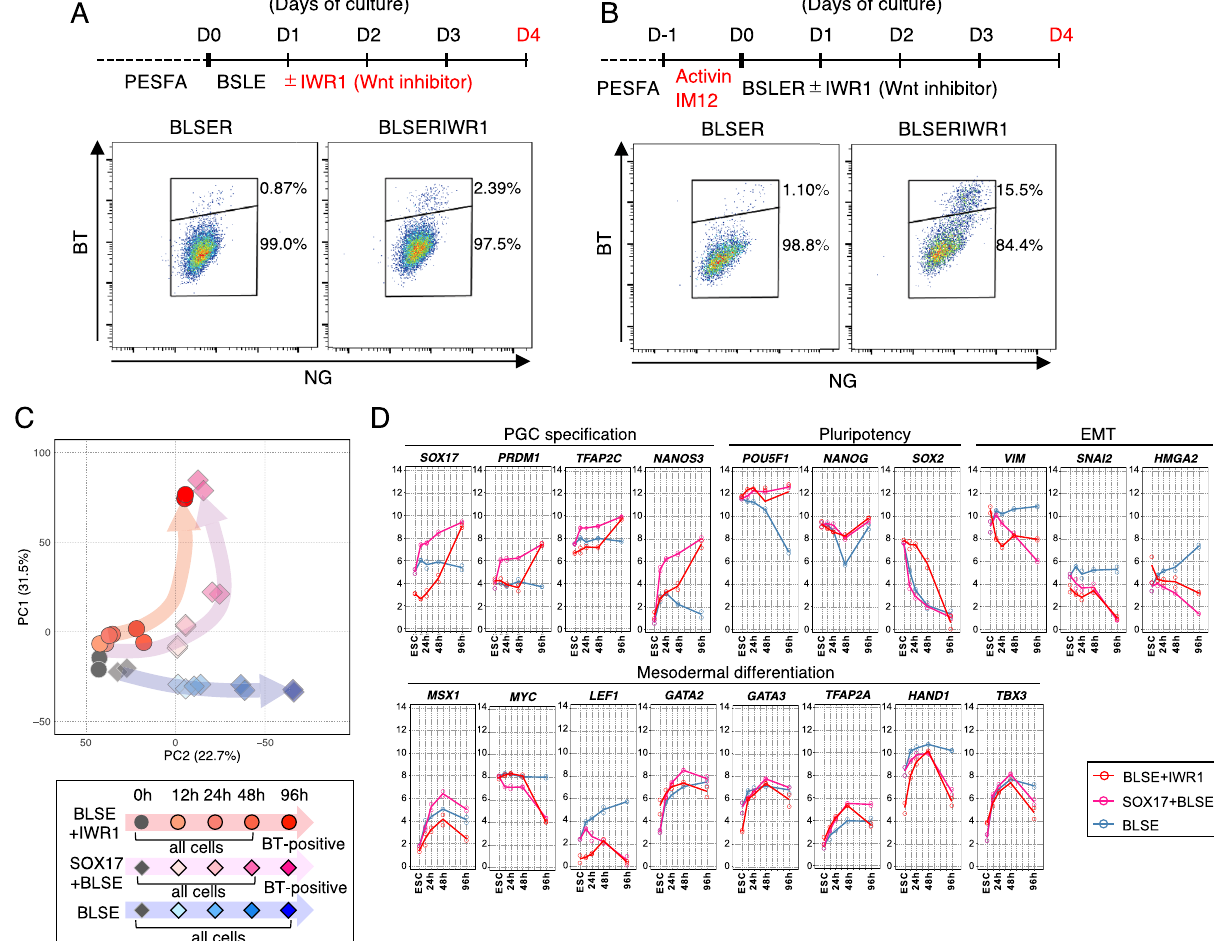
Figure 3. Efficient induction of BTNG-positive cells in the presence of IWR1. ( A ) Enhanced induction of BTNG-positive cells with IWR1. Shown are the schematic time course of the BTNG-positive cell induction with IWR1 (top) and a representative FACS plot of cells at day 4 of induction (bottom). ( B ) Further enhancement of the BTNG-positive cell induction with the preculture period and IWR1. Shown are a schematic time course of the BTNG-positive cell induction with the preculture period and IWR1 (top) and a representative FACS plot of cells at day 4 of induction (bottom). ( C ) Differentiation trajectories during the induction of BTNG-positive cells with BLSE + IWR1. Shown are PCA plots of cjESCs and cells at 12, 24, 48, or 96 h of culture under the condition indicated. The differentiation trajectories under the conditions with SOX17 + BLSE and BLSE alone were the same as in Fig. 2A. ( D ) Expression dynamics of representative genes during the BTNG-positive cell inductions with BLSE + IWR1, SOX17 + BLSE and BLSE alone. Graphs show the expression levels of genes involved in PGC specification, pluripotency, EMT and mesodermal differentiation. Each plot is based on duplicated RNA-seq analyses. The mean values are connected by a line. The analyses in this figure were performed using the common genes between marmosets and humans (15,755